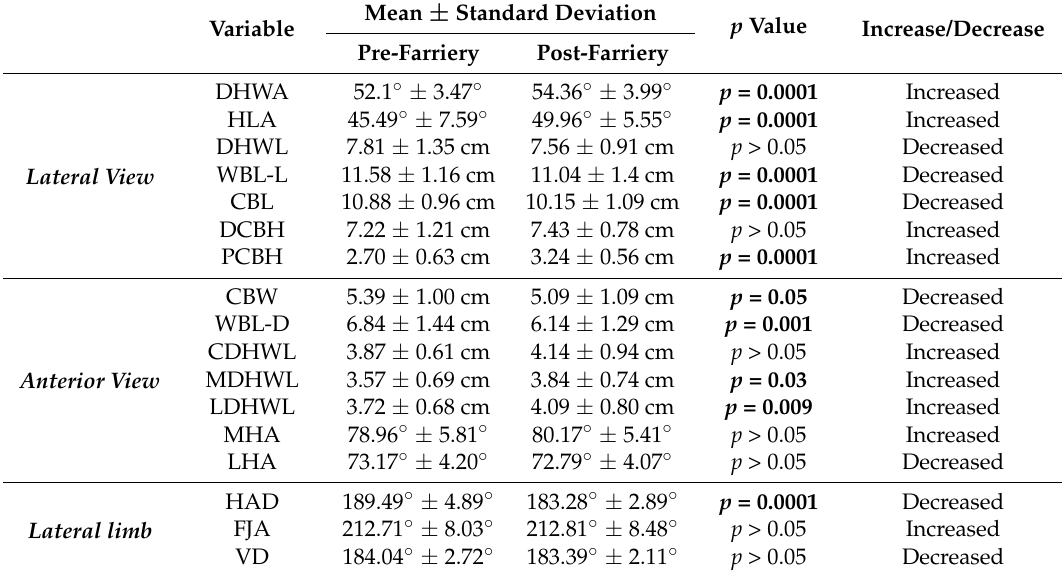
Table 5. Differences between hoof measurements pre- and post-farriery. Bold probability values denote statistical significance. (Length, width and height in cm; angles in